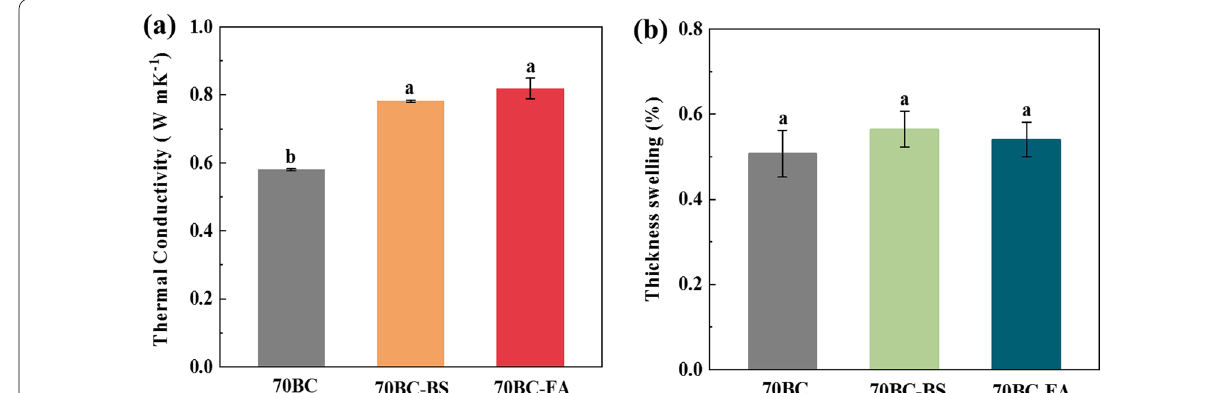
Fig. 1 Thermal conductivity ( a ) and thickness swelling ( b ) of the MOSC biochar particleboards